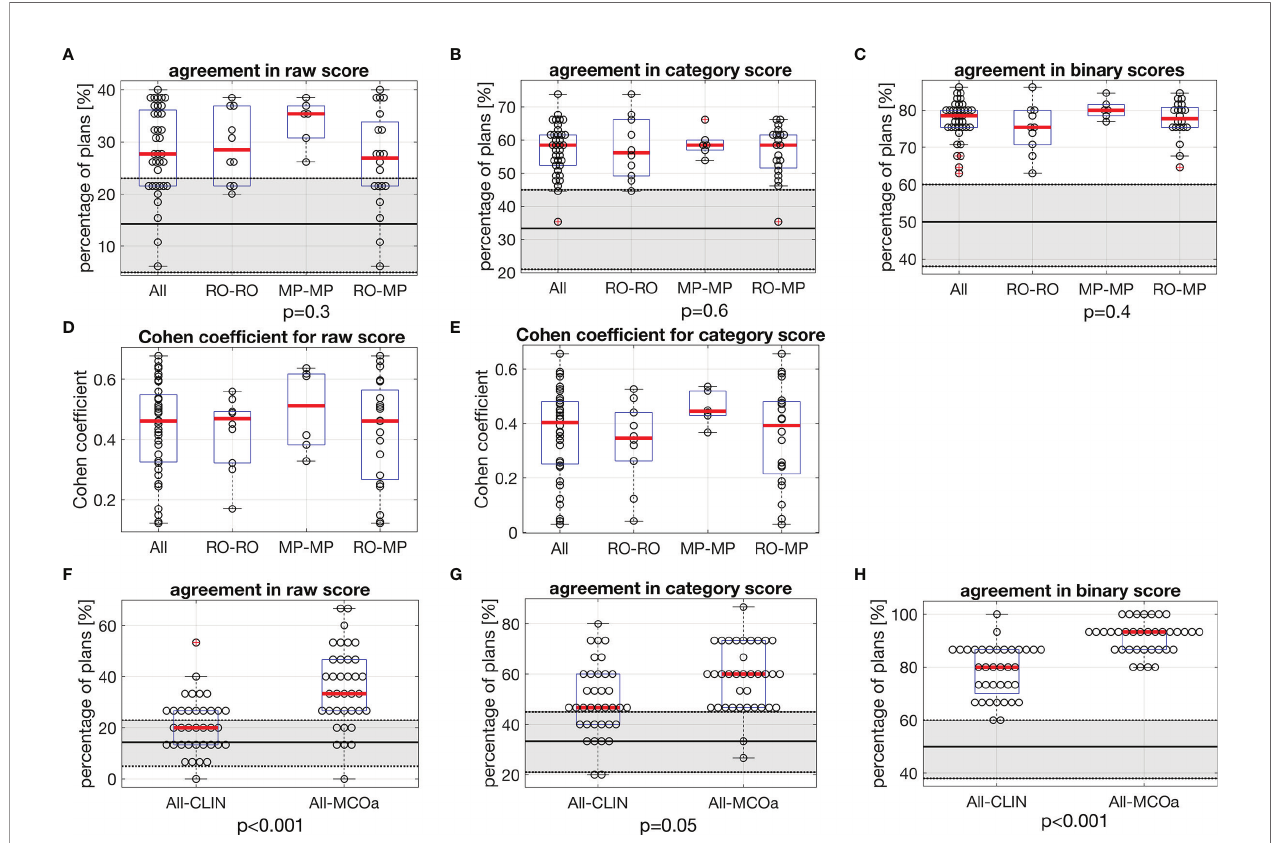
FIGURE 3 | In each panel, horizontal red lines in the boxplots show median values, while the edges of the boxes are the 25th and 75th percentiles. The whiskers extend to the most extreme data points not considered outliers, and the outliers are plotted individually using the “ + ” symbol. (A – C) Each marker shows for one of the unique 36 observer pairs in this study the percentage of 65 evaluated plans for which they agree in (A) raw score, (B) category score, and (C) binary score. In each panel, the fi rst boxplot includes the data for all 36 observer pairs (All). For the other three boxplots, the data are split according to subgroups of observer pairs: RO – RO, pairs consist of two ROs; MP – MP, pairs consist of two MPs; RO – MP, pairs consist of one RO and one MP. Gray zones show expected distributions of agreement percentages in case of random, uncorrelated scoring by the observers in a pair, with the expected value denoted by the solid black line and the 95% con fi dence interval shown by the dotted borders. For observed agreements outside the gray zones, the difference with the expected score for random scoring is statistically signi fi cant. The p-values relate to ANOVA tests between subgroups RO – RO, MP – MP, and RO – MP of all observer pairs. (D, E) Corresponding Cohen ’ s coef fi cients for raw and category scores. (F – H) Comparisons between observed agreement percentages for CLIN plans for all observer pairs, compared with observed agreement percentages for MCOa plans (generated with the optimal wish-list) for all observer pairs. The p-values were established with Wilcoxon ’ s signed- rank tests. Gray zones: as in panels (A – C) . RO, radiation oncologist; MP, medical physicist; CLIN,